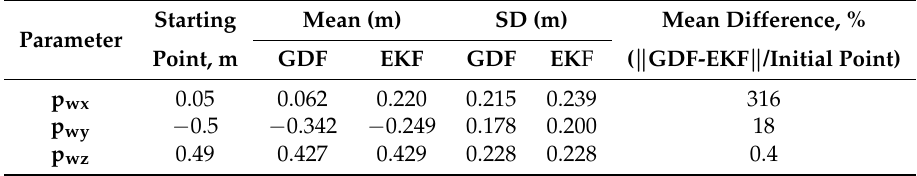
Table 2. Statistical Analysis of the EKF and GDF Estimated Wrist Trajectories. Starting Mean (m) SD (m) Mean Difference, % Parameter Point, m GDF EKF GDF EK F ( (cid:107) GDF-EKF (cid:107) /Initial Point) p